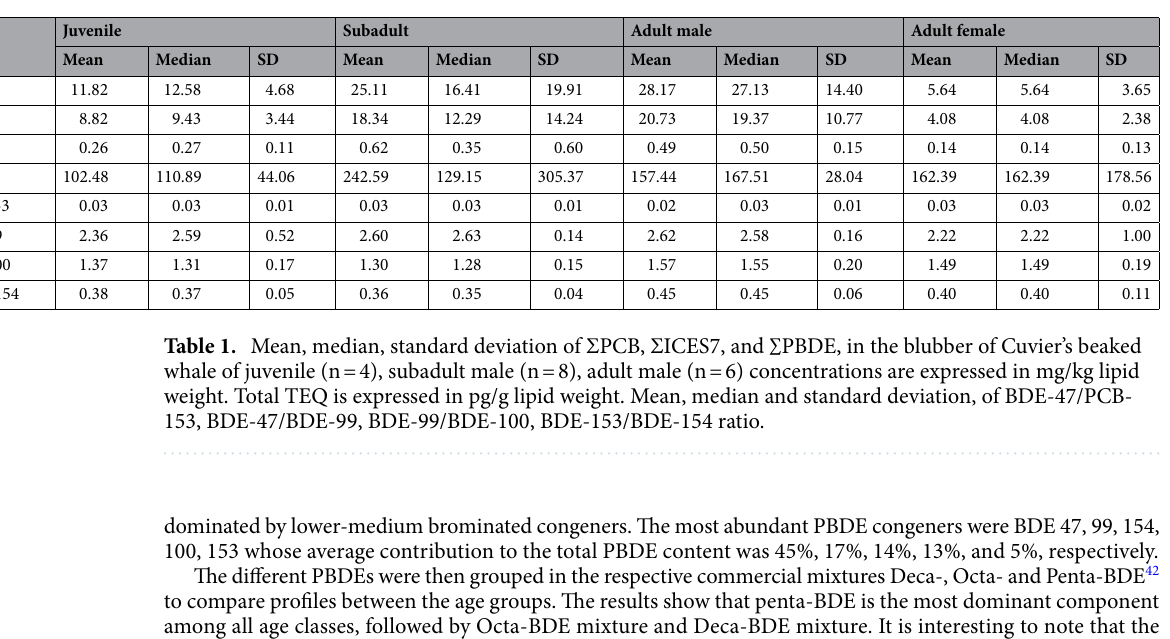
Figure 2. PCB levels in the blubber of Cuvier’s beaked whale in the three age classes: juvenile (light green), subadult (medium green) and adult (dark green). ( a ) Boxplots showing ΣPCB concentrations (mg/kg l.w.) in the blubber of juvenile (n = 4), subadult (n = 8) and adult males (n = 6). ( b ) The mean values of each individual PCB congener profiles for all 18 PCB congeners, in the age classes. Error bars represent standard errors (SE).